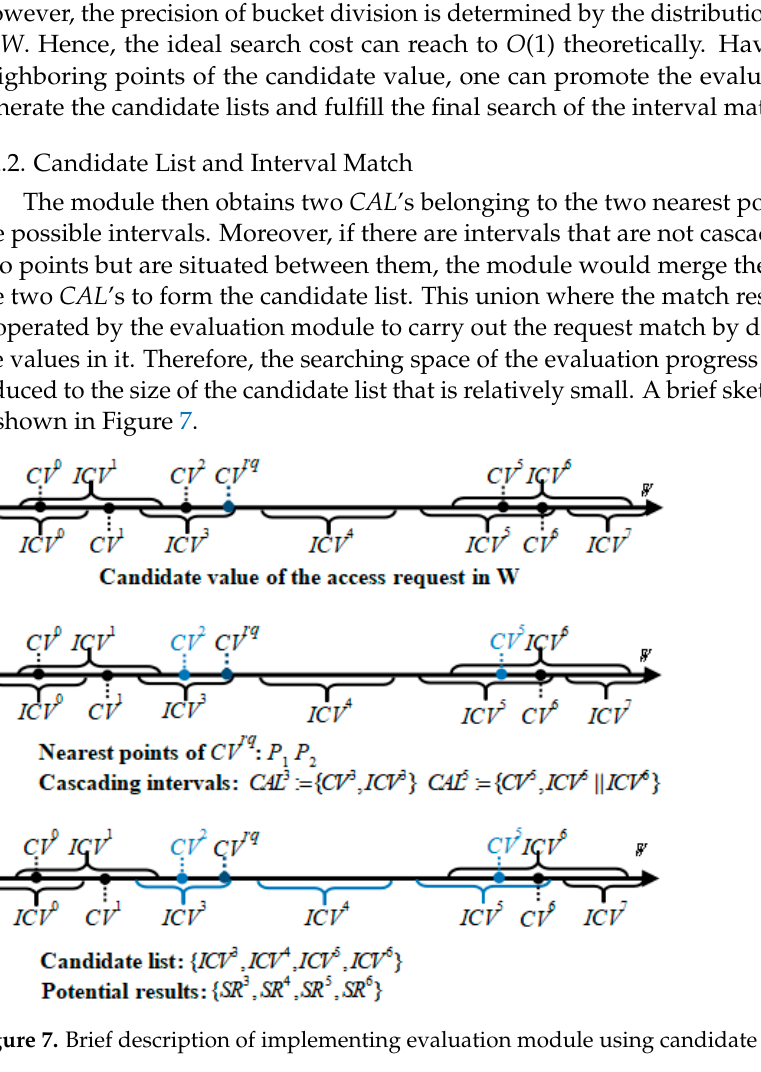
Algorithm 3. Interval Policy Match